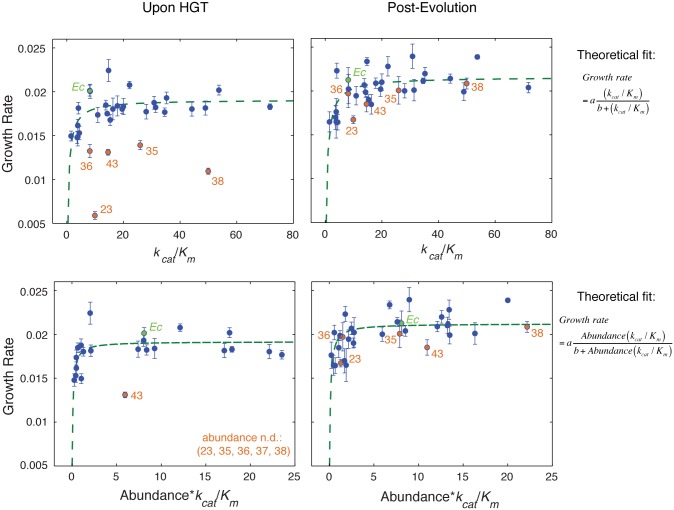
Fitness landscape of HGT strains is largely explained by flux dynamics theory.A) Relationship between activity (k
cat/K
m) of the purified orthologous DHFR proteins and growth rate of the naive HGT strains (prior to evolution experiment). Strains that exhibit the most dramatic drop in fitness (DHFR-23, 35, 36, 38, and 43) are highlighted in orange (see Fig 1C). Wild type E. coli is labeled Ec. No correlation between fitness and activity exists (R = 0.34, p-value = 10−1) when all points are included (see Fig 4A). However, after excluding the outliers (DHFR-23, 35, 36, 38, and 43), the relationship between activity and growth follows flux dynamics theory that predicts that growth rate is proportional to total folate turnover (see the equation on the right; constants a and b depend on the number of enzymes and topology of the metabolic network) (green line, p-value = 10−4). B) Growth rate and activity after the evolution experiment. Similar to (A), fit also excludes DHFR-23, 35, 36, 38, and 43, but they nonetheless migrate to the prediction of the flux dynamics theory (n.d.–non-detectable). C-D) Relationship between growth rate and the product of relative intracellular abundance (from total lysates) and activity (k
cat/K
m). Theoretical fit also excludes DHFR-23, 35, 36, 38, and 43. (p-values are <10−4 for all theoretical fits in panels (A-D)).